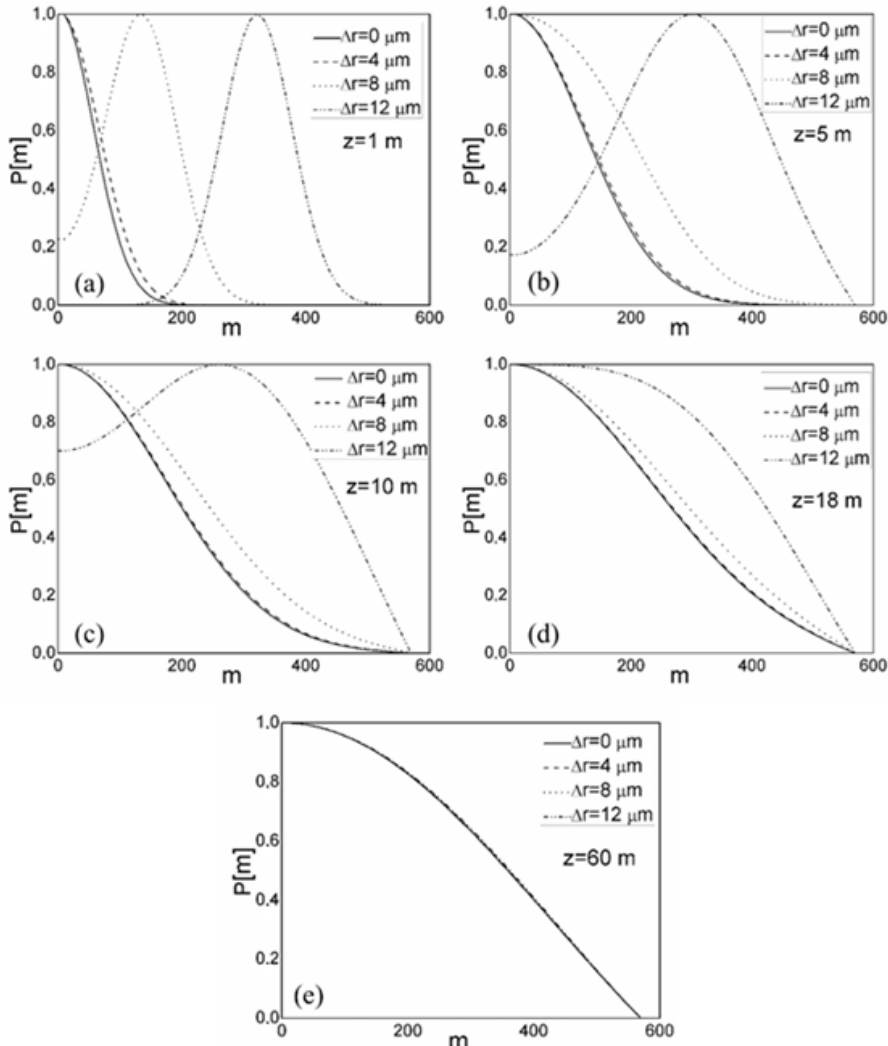
Figure 2. Normalized output modal power distribution P ( m , λ , z ) over a range of radial offsets ∆ r obtained by numerically solving the TI PFE (2) at different fiber lengths: ( a ) z = 1 m, ( b ) z = 5 m, ( c ) z = 10 m, ( d ) z = 18 m, and ( e ) z = 60